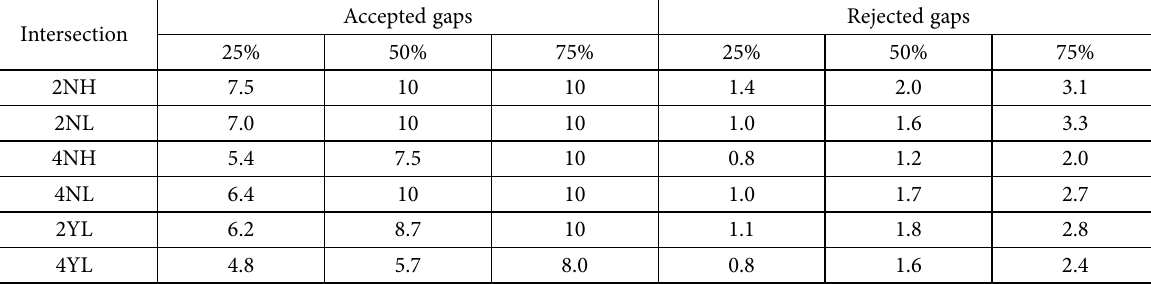
Table 2. Quartiles of accepted and rejected gap distributions by intersection [s]